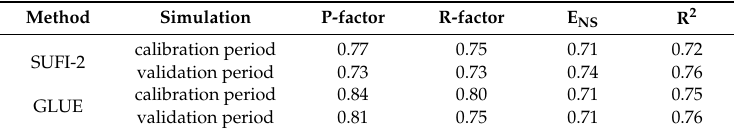
Table 2. Comparison of simulation results from the two methods.